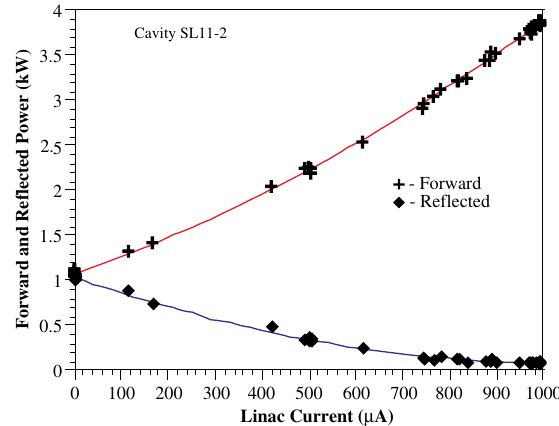
FIG. 16. Distribution of cavity gradients producing 3 arcs per day (from